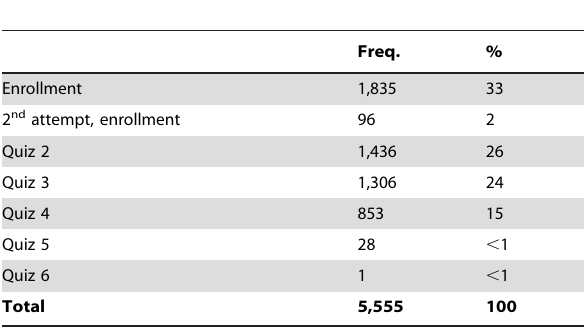
Table 1. Number of comprehension quizzes completed by HIV-infected adults enrolled in a tuberculosis prevention trial, Botswana 2004–2008.